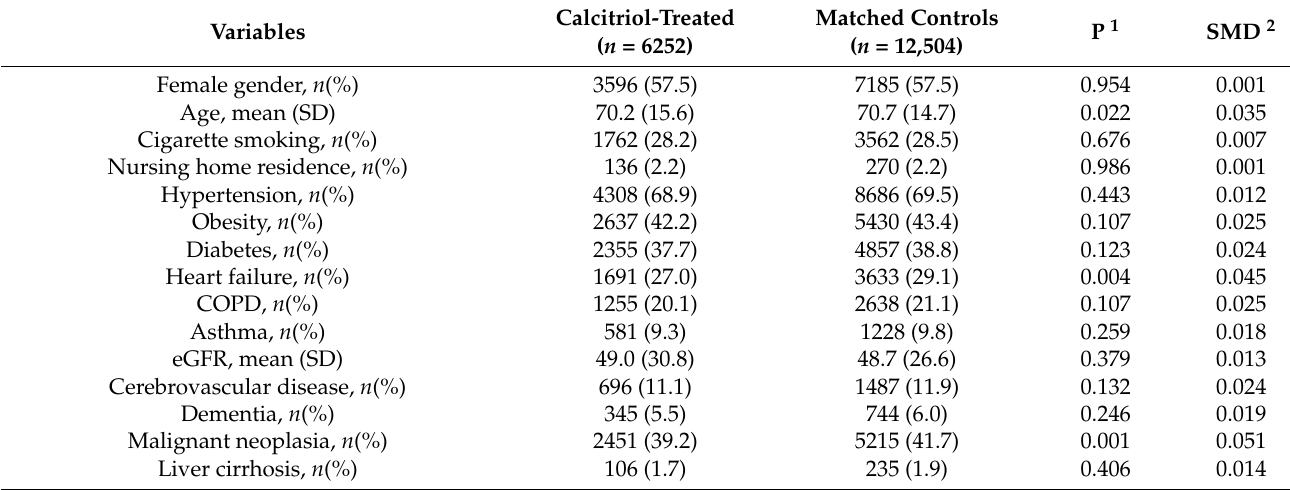
Table 1. Main clinical characteristics of the patients on calcitriol treatment and matched controls.